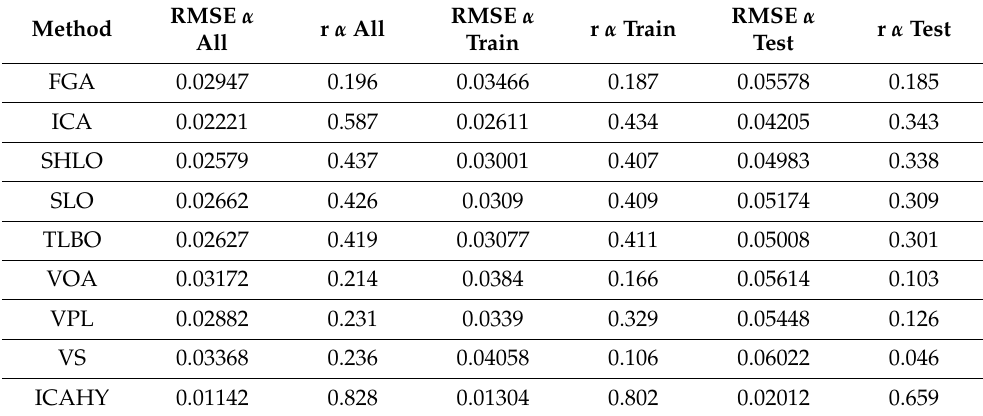
Table 4. RMSE and r metrics for the swelling degree α , resulting from applying the tested algorithms for optimizing the neural network architecture and weights using the entire dataset (“all”), the training split (“train”), and subsequently testing on the test split (“test”). ICAHY is our